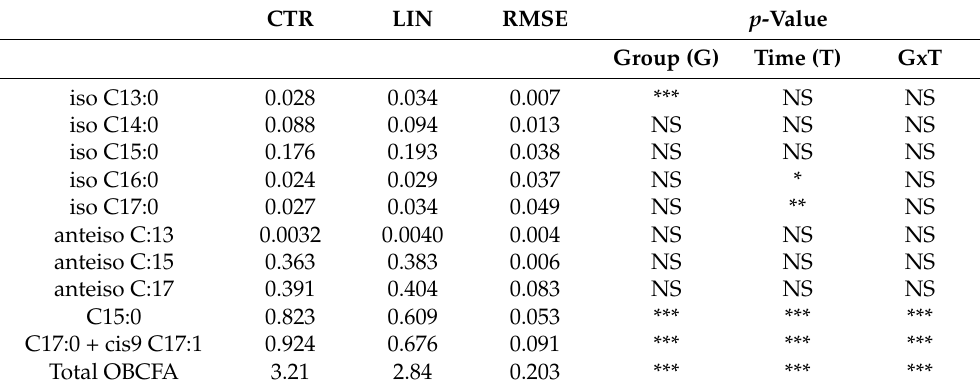
Table 4. Goats’ odd- and branched-chain fatty acid content (mean value, g/100 g of total fatty acids) of control (CTR) and linseed supplementation (LIN) groups.